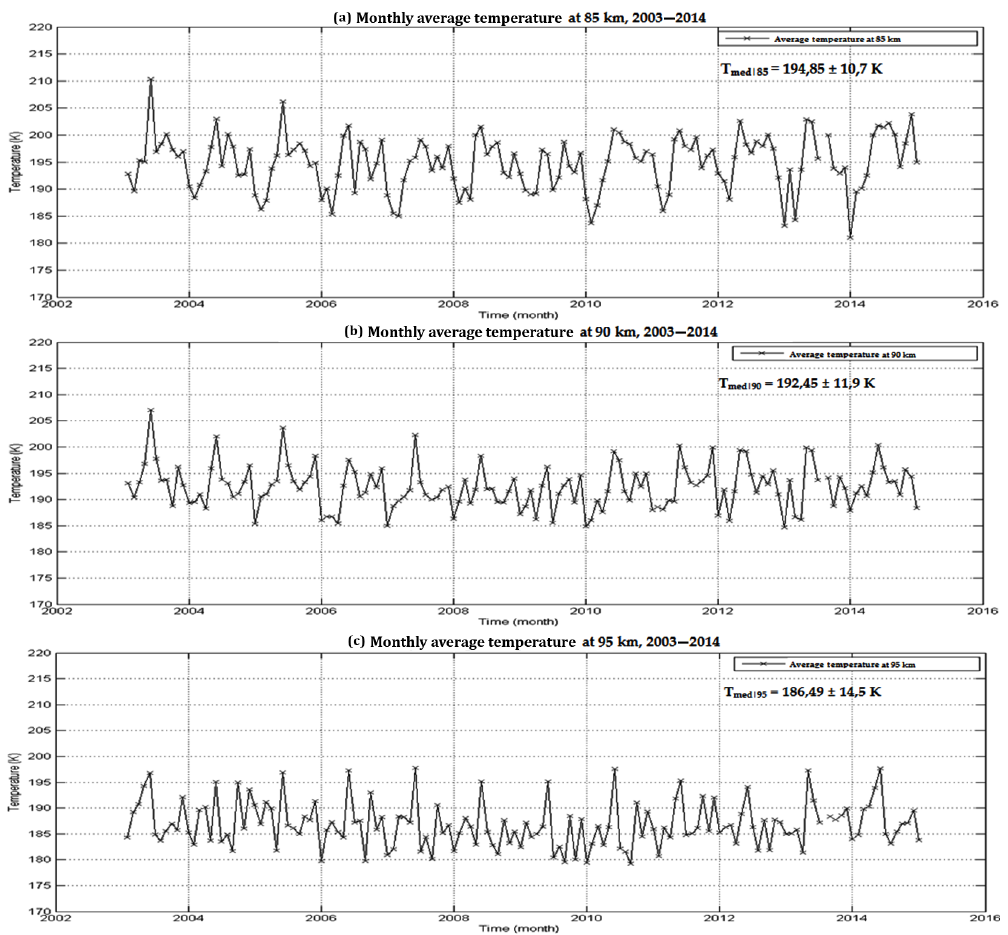
Figure 5. Monthly average temperature values at 85 (a) , 90 (b) and 95 (c) km height derived within a ± 7.5 ◦ grid over Santa Maria, for the 2003–2014